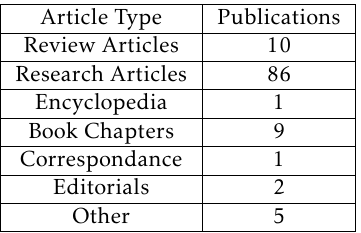
Table 2. Publications per year in springer